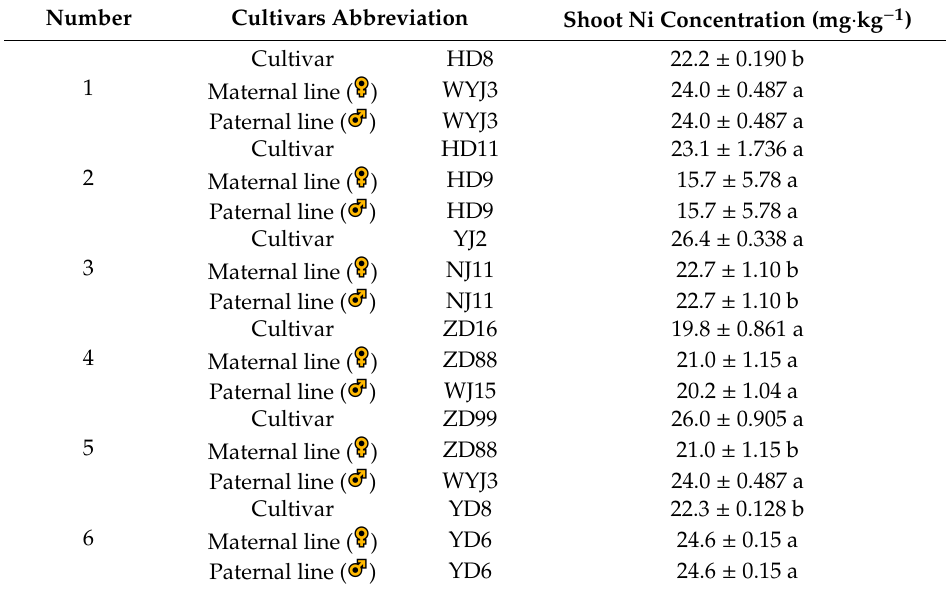
Table 3. The Ni concentration in shoots of different rice cultivars and their parents.